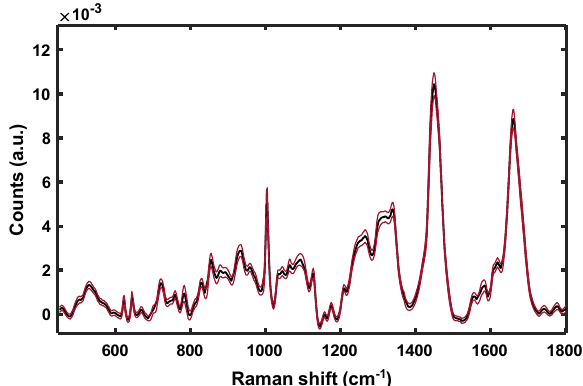
Figure 3. Mean Raman spectrum (black) of breast cancer xenografts exposed to 0, 5 and 15 Gy and acquired at day 3 post-irradiation. The standard deviation at each wavenumber is shown in red.